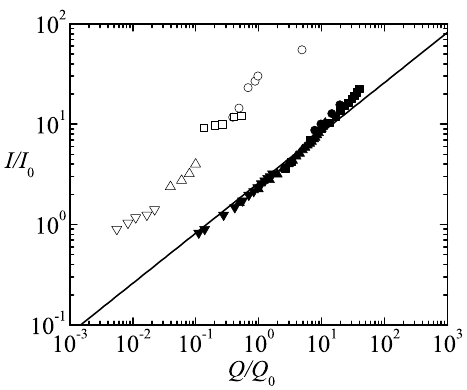
Fig. 4. Current intensity I = I 0 as a function of the flow rate Q = Q 0 . The open and solid symbols correspond to the needle and cap- illary configurations, respectively. The solid line is the function (1).